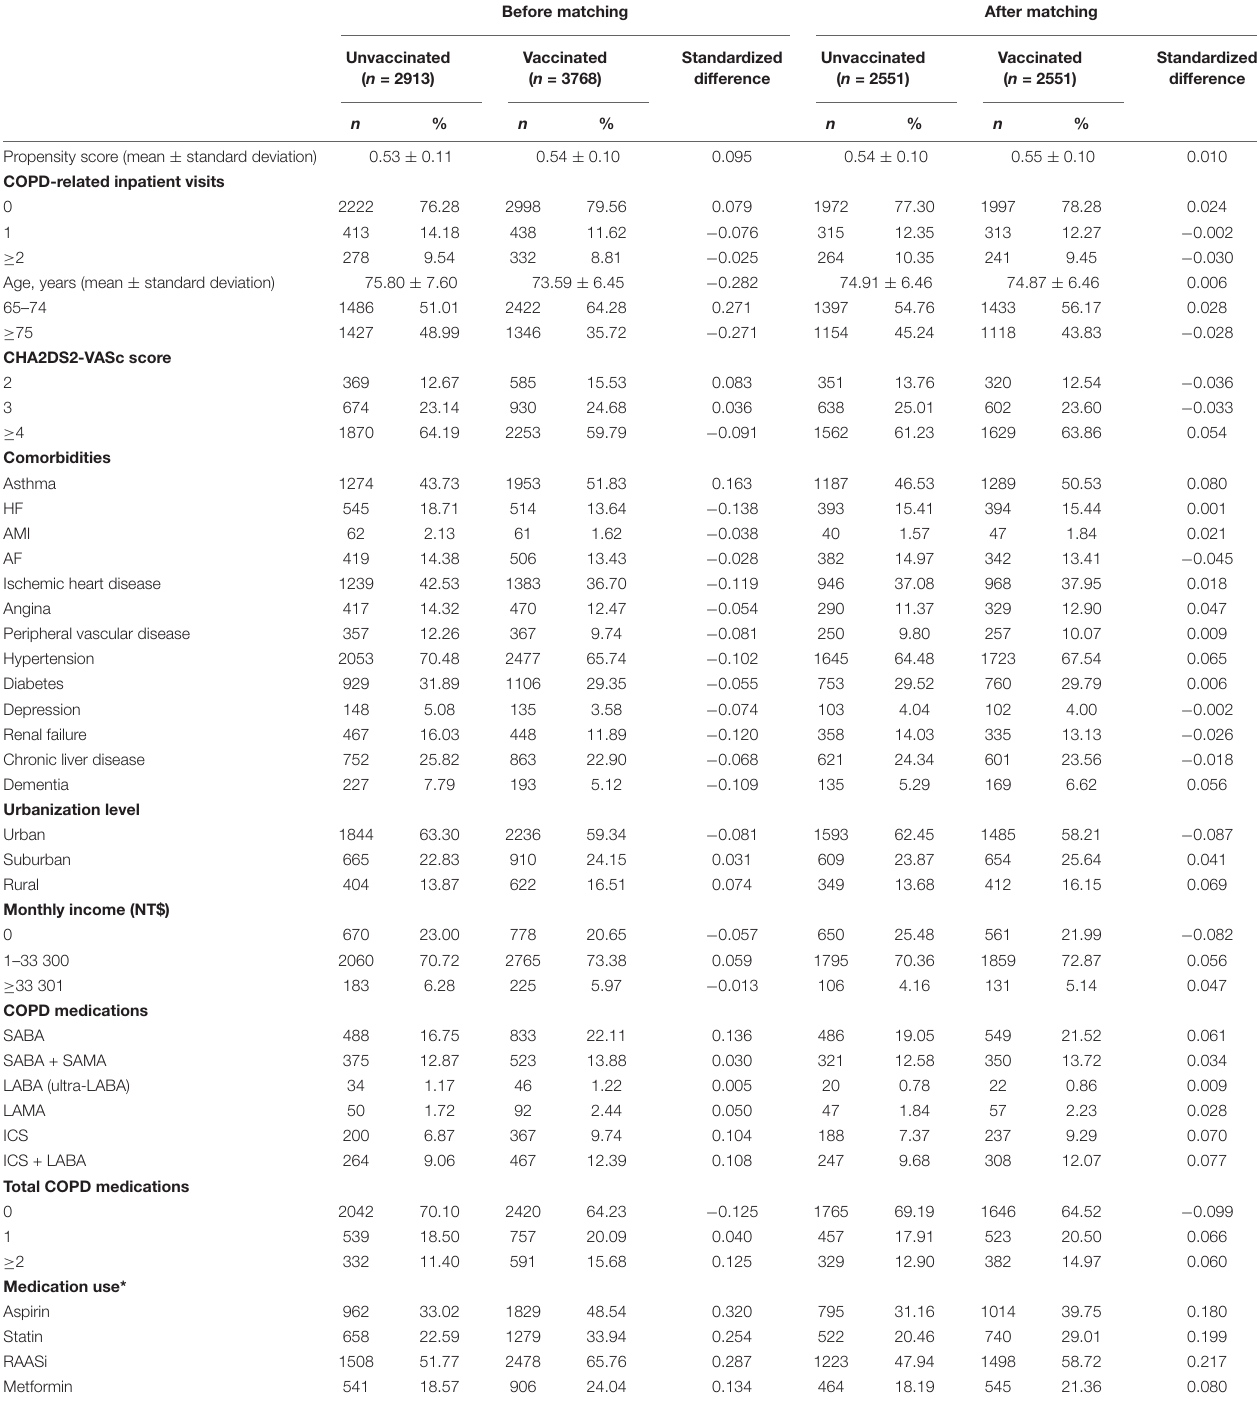
TABLE 1 | Pooled baseline characteristics, balanced before and after propensity score matching.